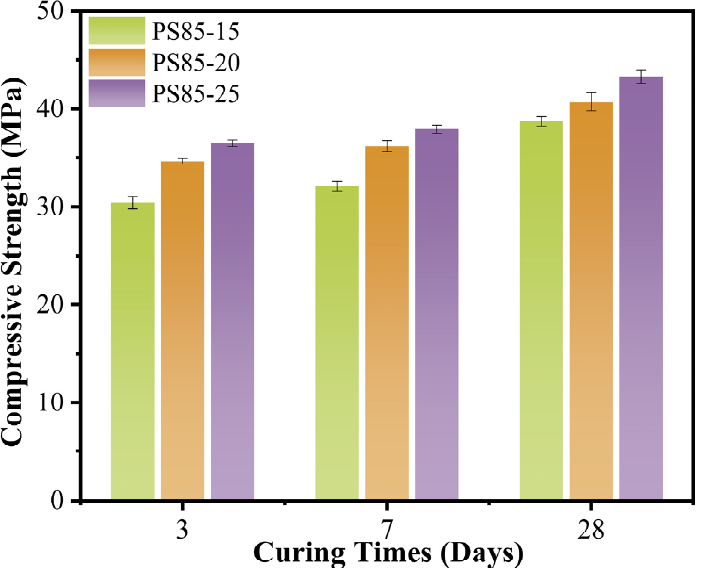
Figure 2. The compressive strength of WUFA-PS geopolymer mortars with different activator ad- mixtures.